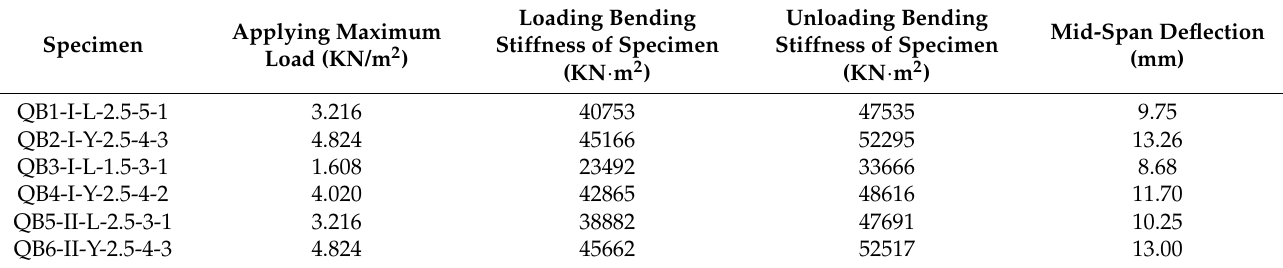
Table 4. Mid-span deflection and bending stiffness of each specimen under maximum load.